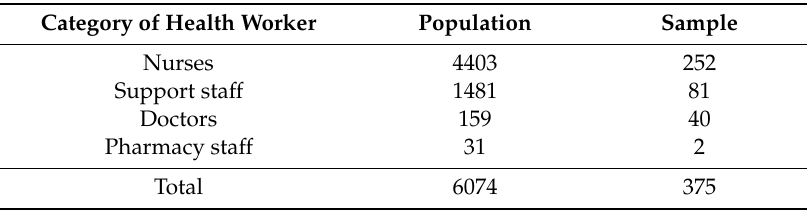
Table 1. The sampling